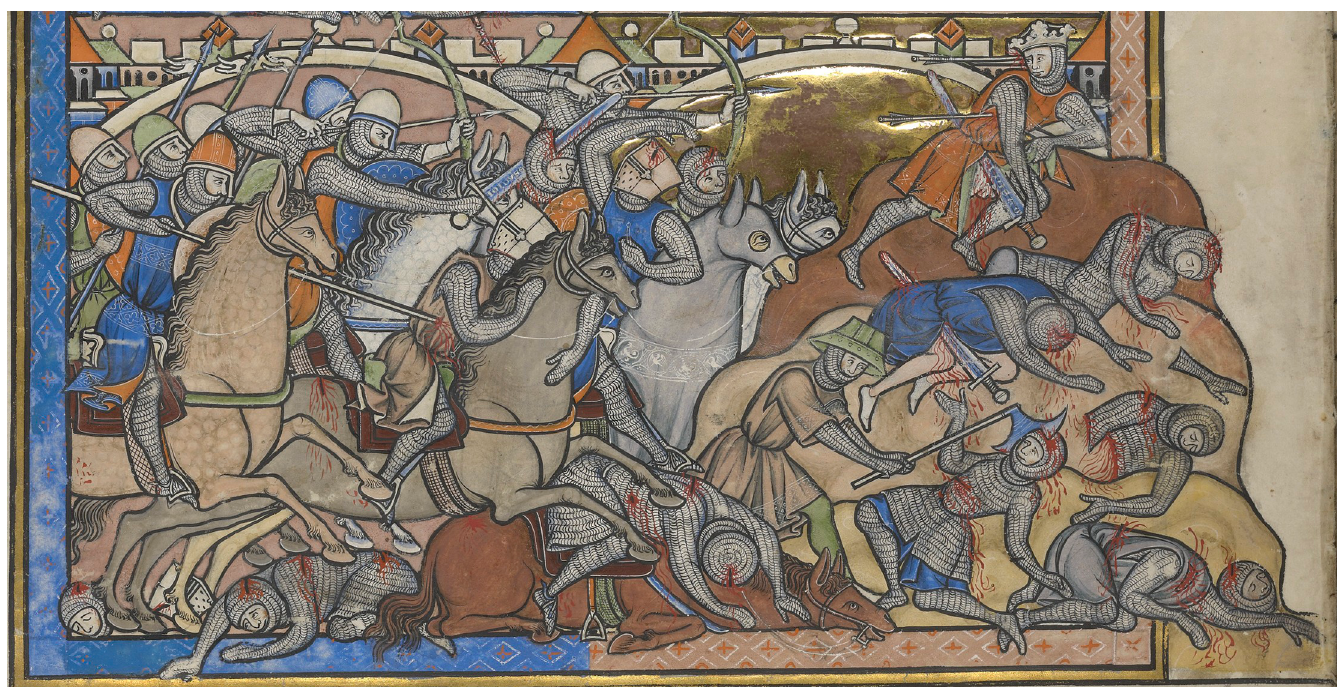
Fig 9. Detail from the Maciejowski Bible, depicting contemporary weapons and the intensity of hand-to-hand combat. (Image: The Morgan Library & Museum. MS M.638, fol. 34v. Purchased by J.P. Morgan (1867–1943) in 1916).